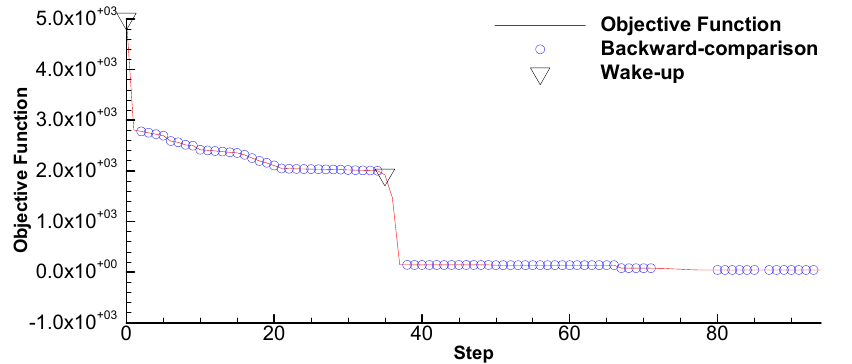
Figure 10. Variation in the objective function by the VSCGM + the wake-up and backward-comparison strategies, for Case 2. Table 4. Optimal design of Case 2.